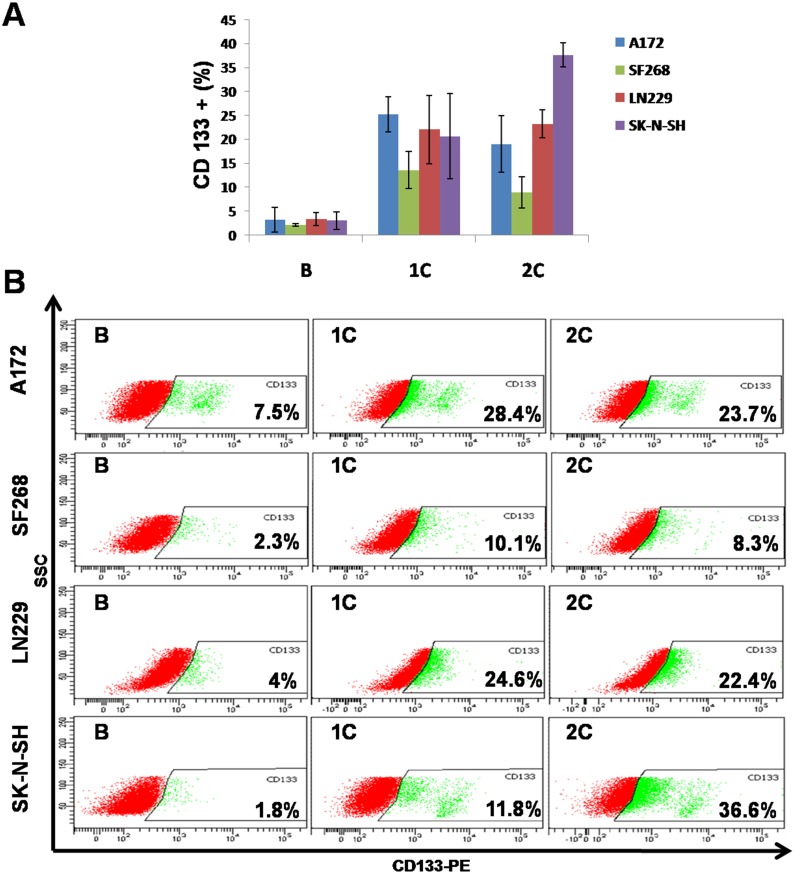
Modulation of CD 133 expression by TMZ treatment.A) Flow cytometry analysis of percentages of CD133 positives in tumor cell lines using TMZ treatment B: basal cells, 1C: first TMZ cycle; 2C: second TMZ cycle. Data were calculated from three independent experiments. B) Representative flow cytometry data for CD133 expression. SSC: side-scattered light.